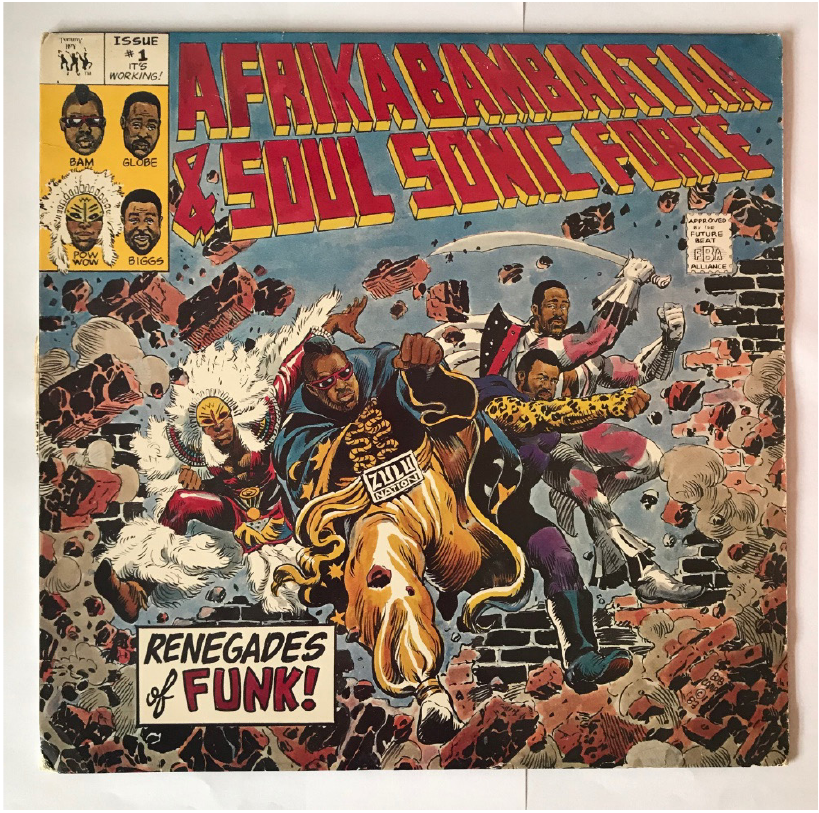
Figure 1. Front cover of “Renegades of Funk” illustrated by Bob Camp. Photograph by